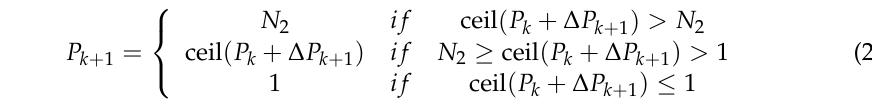
Figure 3. Ideal functions u and v of the proposed AAVE method. ( a ) function v ; ( b ) function u . 1.